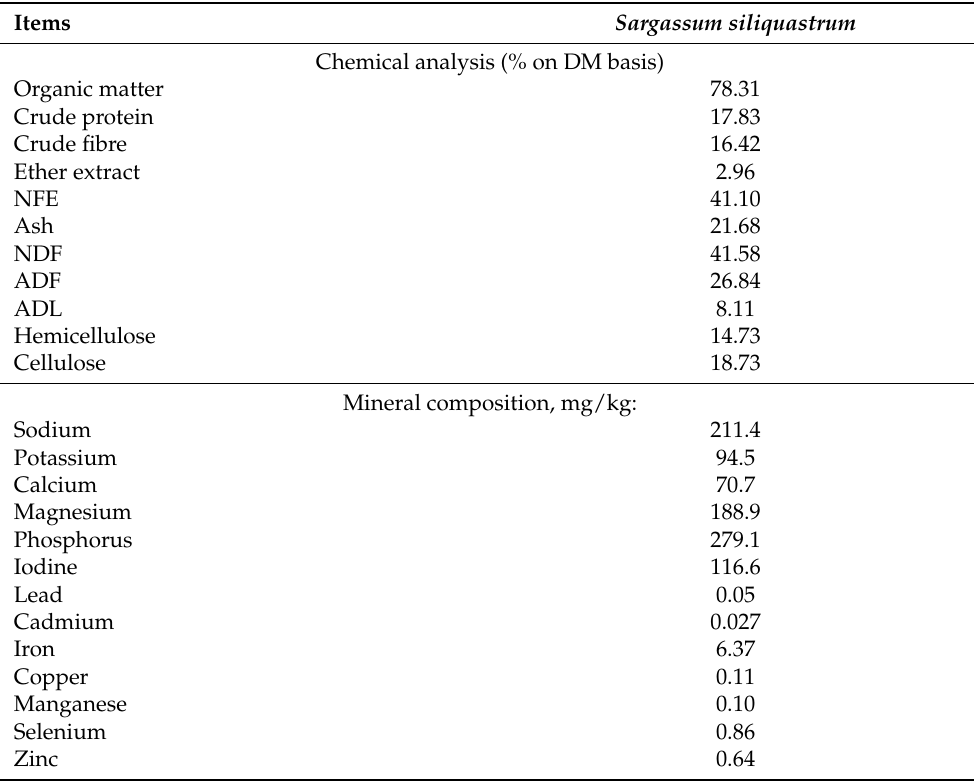
Table 1. The chemical composition of Sargassum siliquastrum